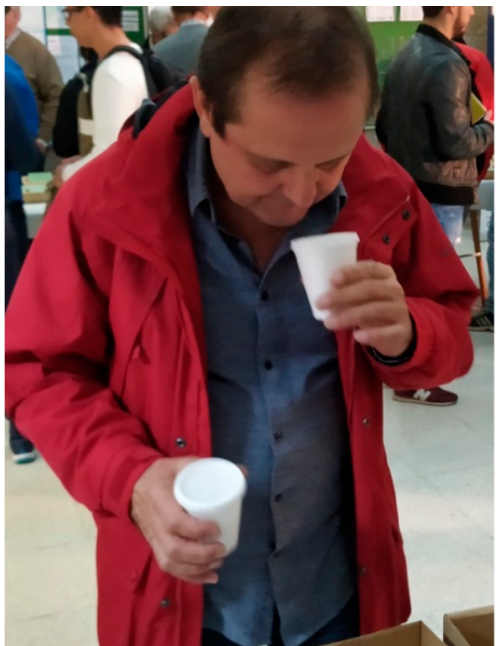
Figure 2. Judge from the sensory panel participating in the triangular sensory test.